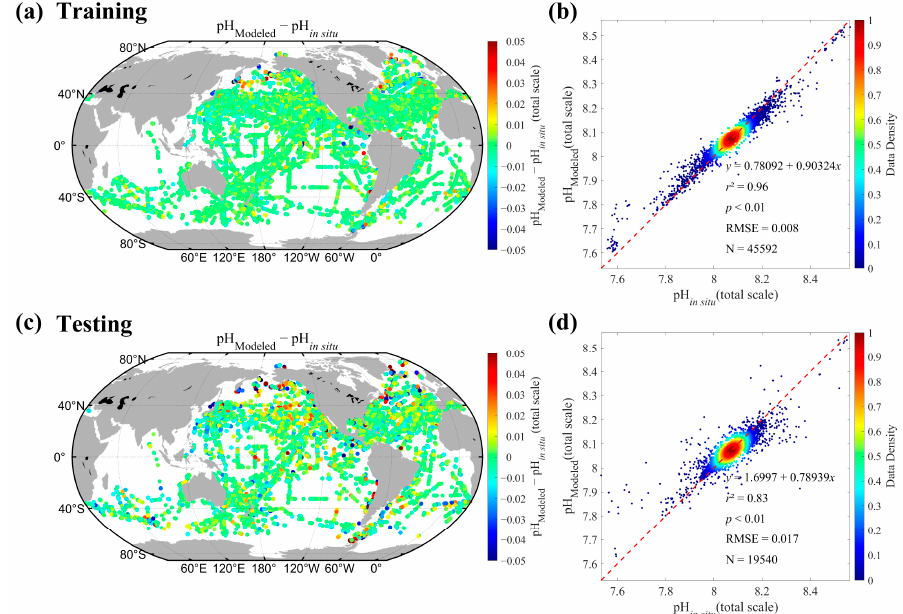
Figure 11. Validation of the pH inversion model based on the RF model with inputs of LON, LAT, SST, Chla, and MLD. Spatial distributions of inversion errors for the pH ( a ) training dataset and ( c ) testing dataset. Point-to-point comparison between in situ pH and modeled results in ( b ) the training dataset (R 2 = 0.96, RMSE = 0.008, and n = 45,592) and ( d ) the testing dataset (R 2 = 0.83, RMSE = 0.017, and n = 19,540). The red dotted line is 1:1